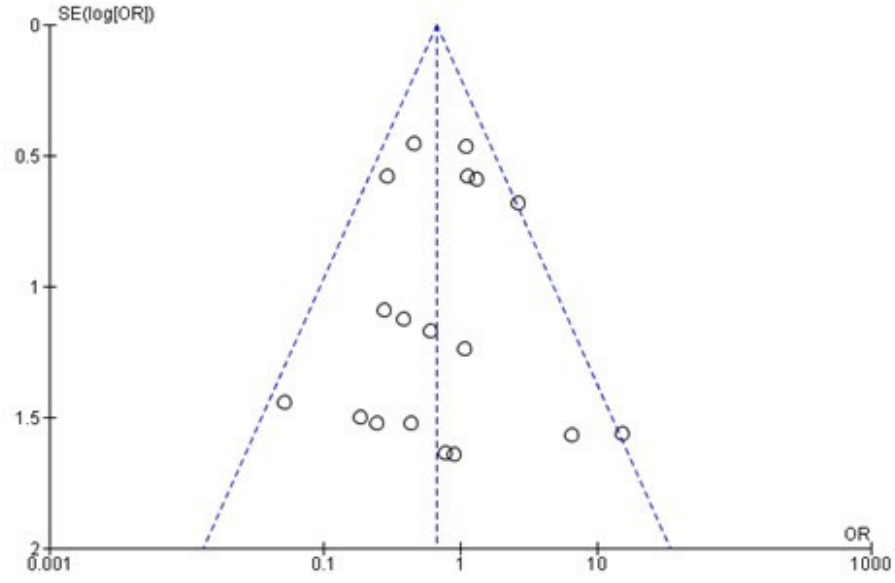
Figure 5. Funnel plot of the zygomatic and regular implant survival rate comparation.